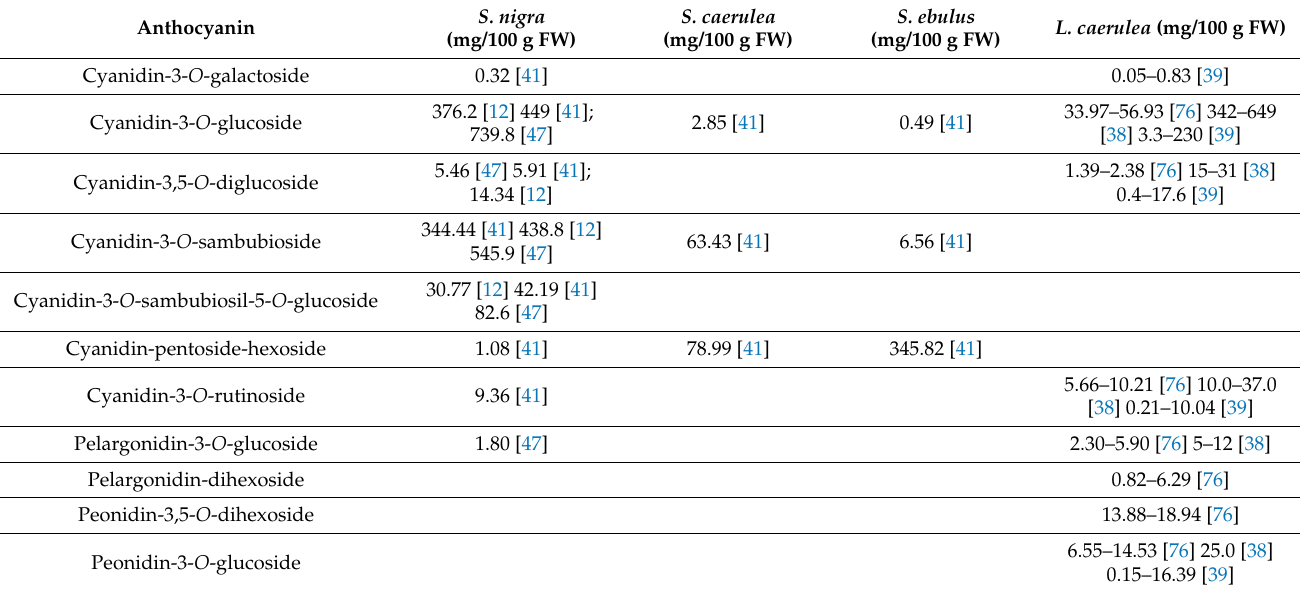
Table 4. Specific anthocyanin contents found in the fruits of the Caprifoliaceae family.